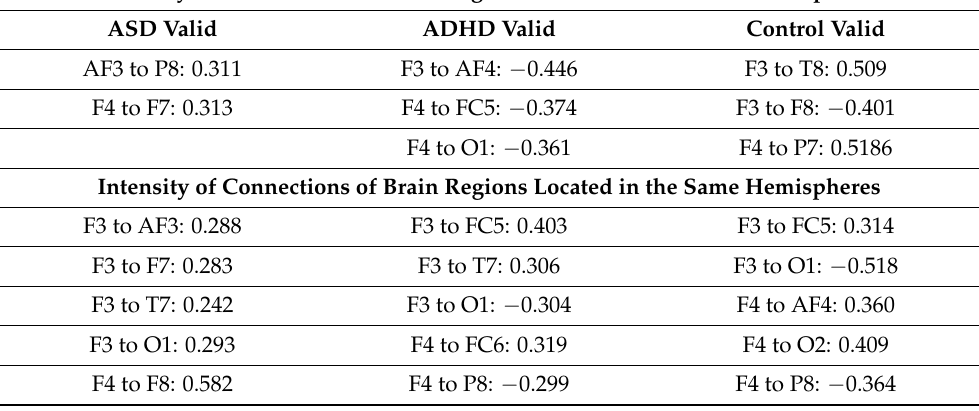
Table 13. Intensity of connections of brain regions located in different and in the same hemispheres for the valid